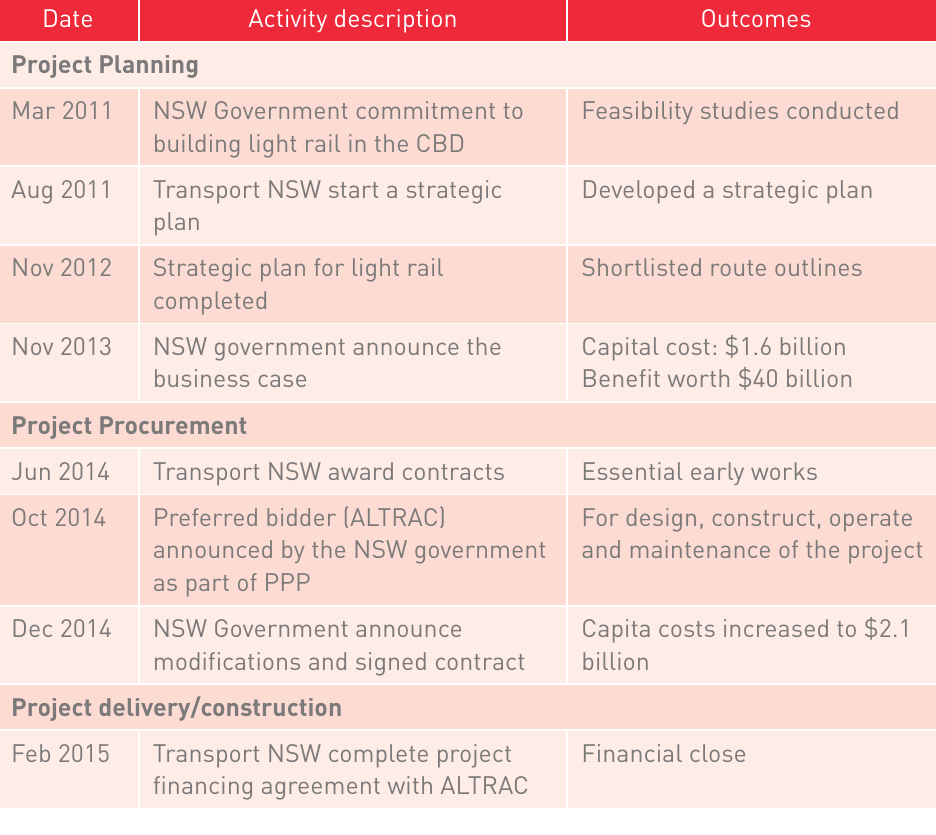
Sequence of activities on the Sydney Light Rail Project from start to date. Activity description